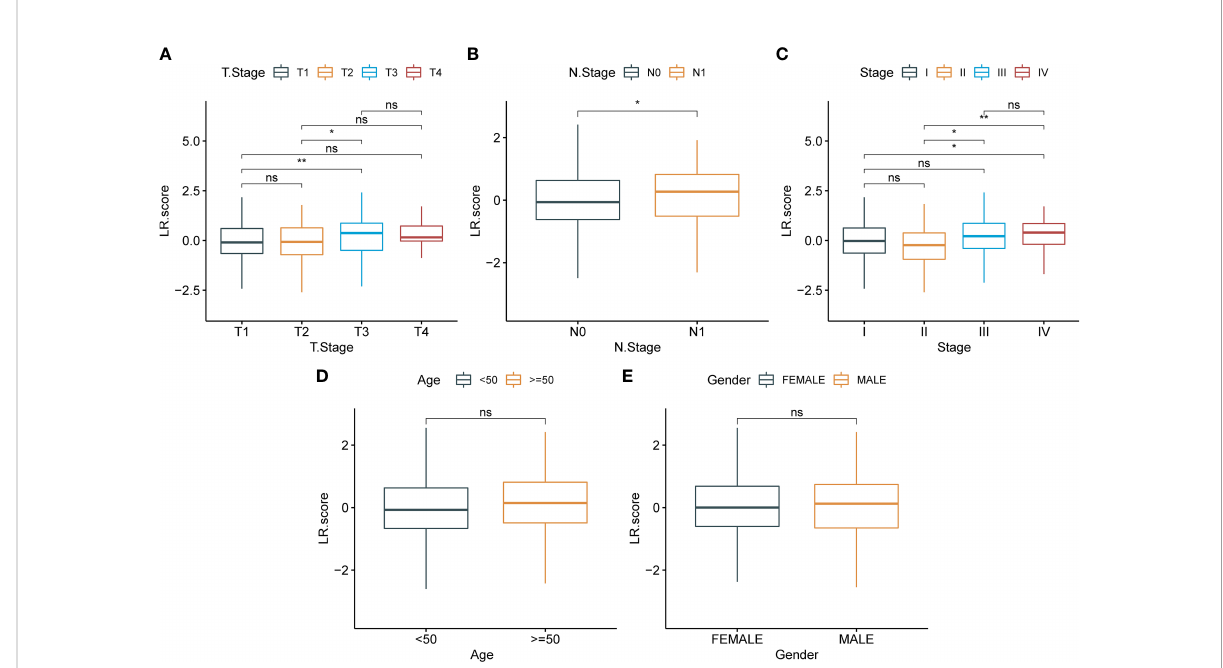
FIGURE 9 Correlation between LR.score and clinical features. (A) : T stage; (B) : N stage; (C) : Total stage; (D) : Age; (E)